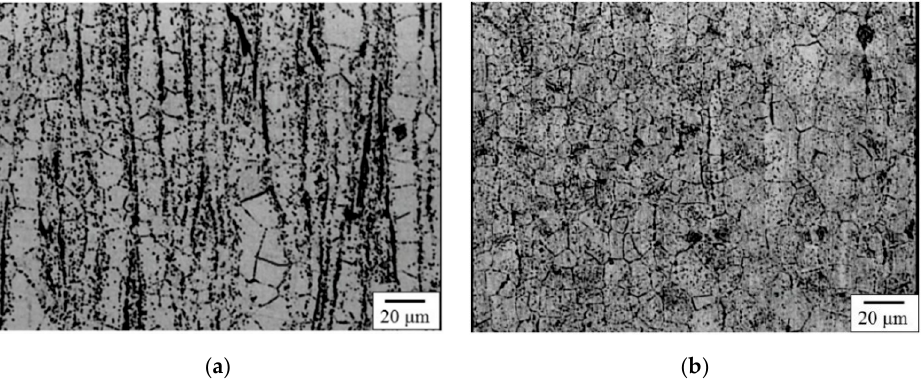
Figure 1. Light microscopy (LM) microstructural images. ( a ) XK105-F and ( b ) XK105-H.